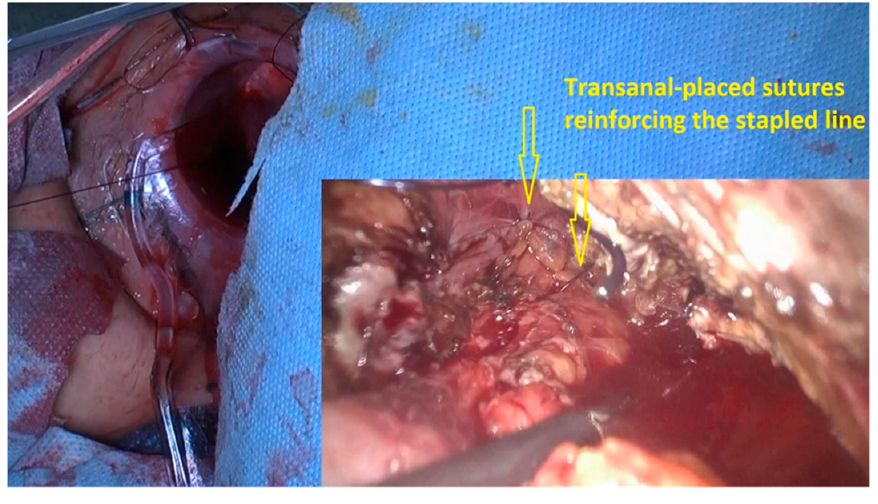
Figure 7. Transanal excision of the involved rectal area. ( a ) Transanal placement of a suture on the shaved area; ( b ) laparoscopic placement of a suture on the shaved area, to assist the colorectal surgeon in identifying the rectal area to be excised; ( c ) introduction of the closed transanal circular stapler (the stapler opening is at the nodule level), and the stapler closing and firing; ( d ) stitches reinforce the stapled line.